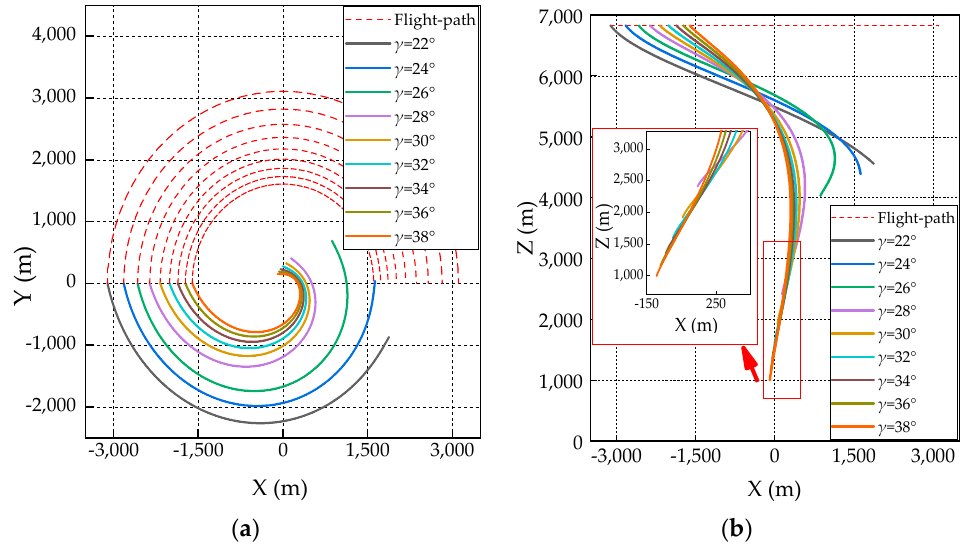
Figure 16. Towline spatial configurations vs. bank angle: ( a ) Two-dimensional projection in horizontal plane. ( b ) Two-dimensional projection in vertical plane.